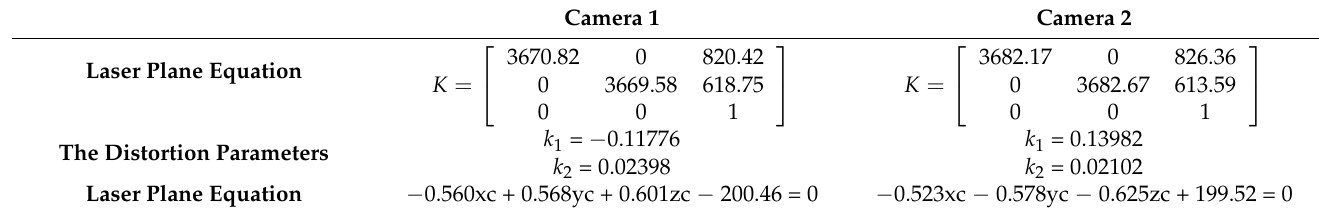
Figure 13. The extrinsic parameters and the fitting laser plane (red) in the second experiment. Table 2. The calibration results are displayed in experiment